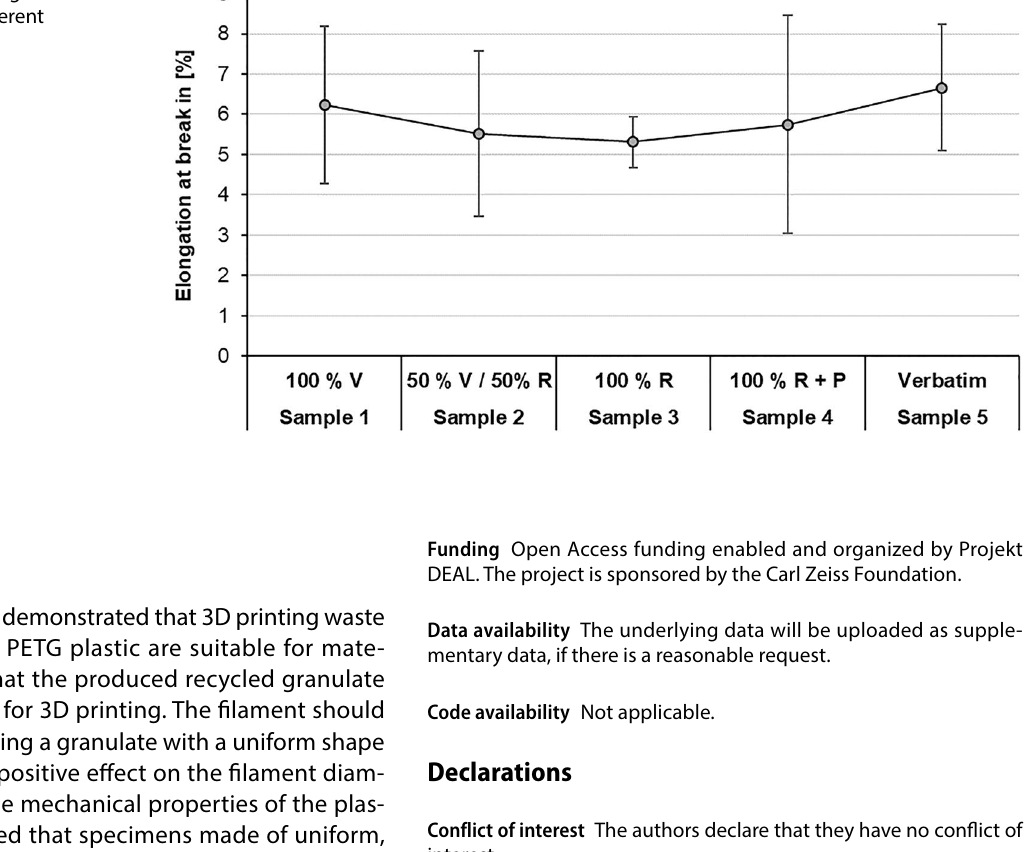
Fig. 14 Overview of elonga- tion at break for the different filament